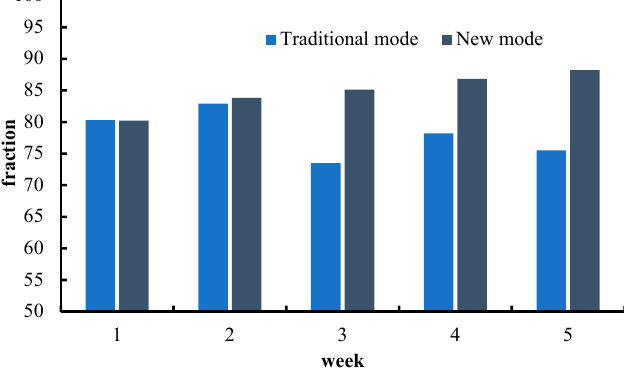
Figure 5. Scoring of 5-week teaching quality under two modes.